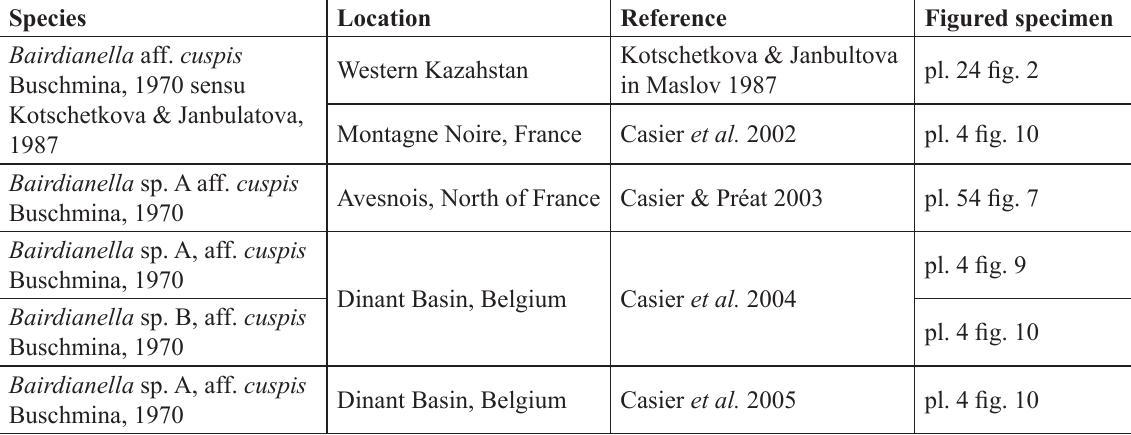
Species Location Reference